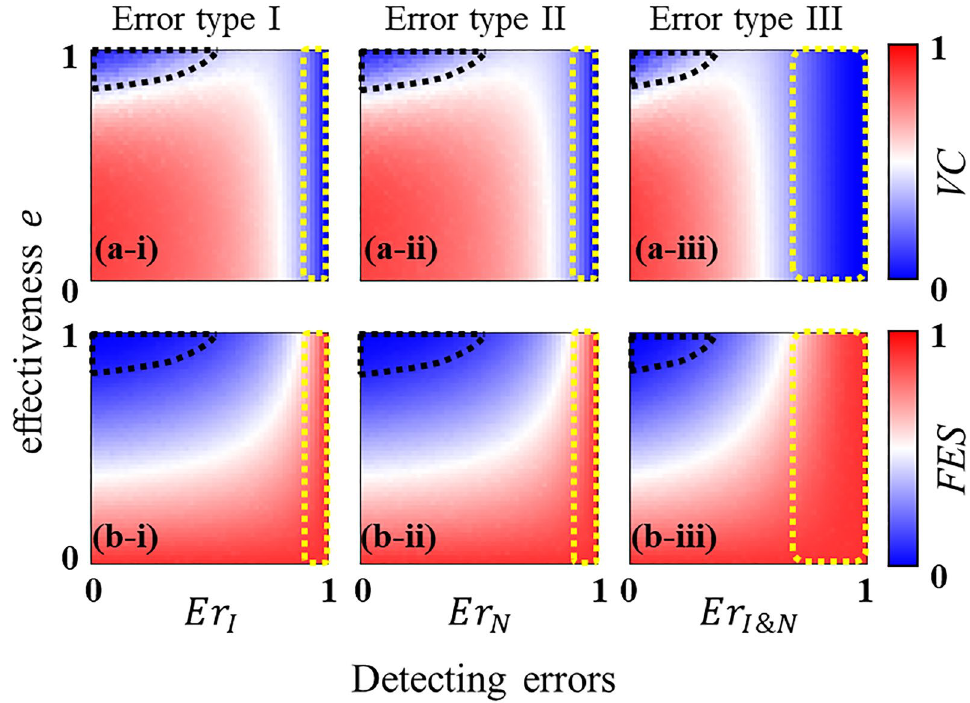
Figure 3. Stationary outcomes of the dynamic vaccination policy. Results are generated in terms of vaccination coverage (VC) and final epidemic size (FES) considering three error types. The dynamic vaccination can successfully mitigate the disease diffusion with a moderate to high level of vaccine effectiveness. A higher degree of detecting error causes a less vaccination coverage (blue region enclosed by yellow dotted line) and thereby, resulting in a higher disease prevalence (red region enclosed by yellow dotted line). Interestingly, a highly effective vaccine requires a less coverage (blue region enclosed by black dashed line in panel ( a )) to attain a disease-free situation (corresponding blue region enclosed by black dashed line in panel ( b )). Relevant parameter values are stated in Table